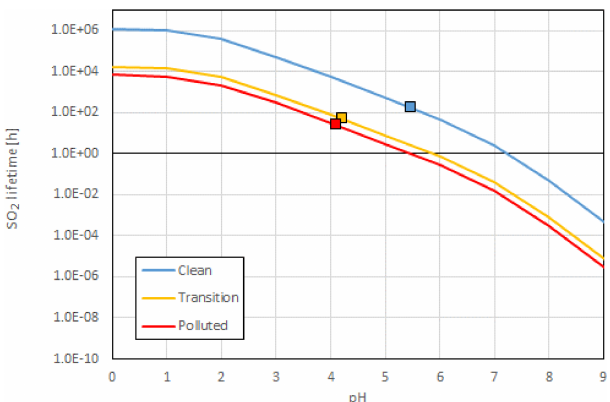
Figure 1. SO 2 lifetime (h − 1 ) due to SO 2 + NO 2 reactive uptake mechanism as a function of aerosol pH under clean, transition, and polluted conditions. Values of relative humidity, temperature, and NO 2 (g) concentrations are based on values in Table